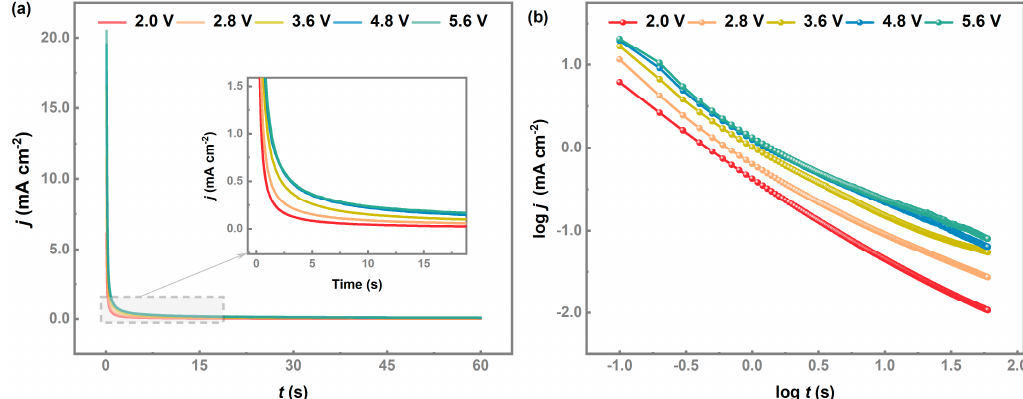
Figure 6. ( a ) Anodic transient current density ( j ) vs. time ( t ) curves; ( b ) Dependence of current density in logarithmic scale (log j ) on the logarithmic scale of time (log t ). Condition: on Hf in the ethanol and acetonitrile ( V / V = 1:1) solution containing 0.06 M Et 4 NHSO 4 at 30 ◦ C and different anodic